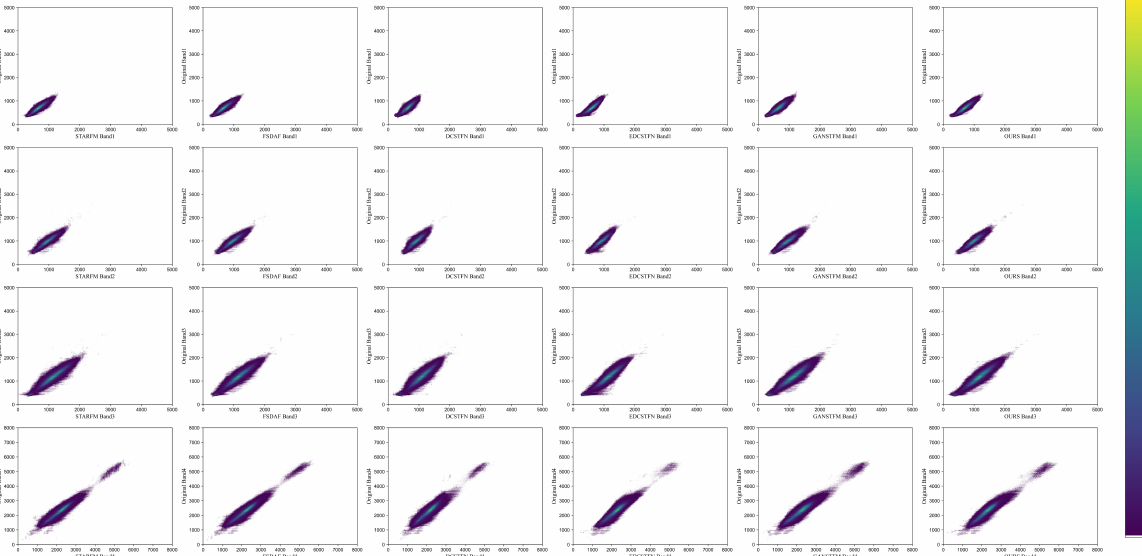
Figure 13. The results are shown in the thermal scatter plot of the LGC